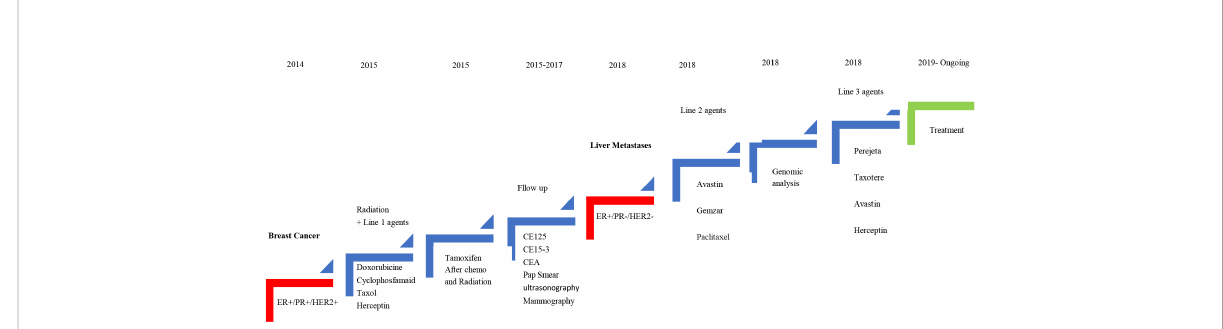
FIGURE 1 Schematic diagram of the patient ’ s clinical course indicating treatment, duration, and disease